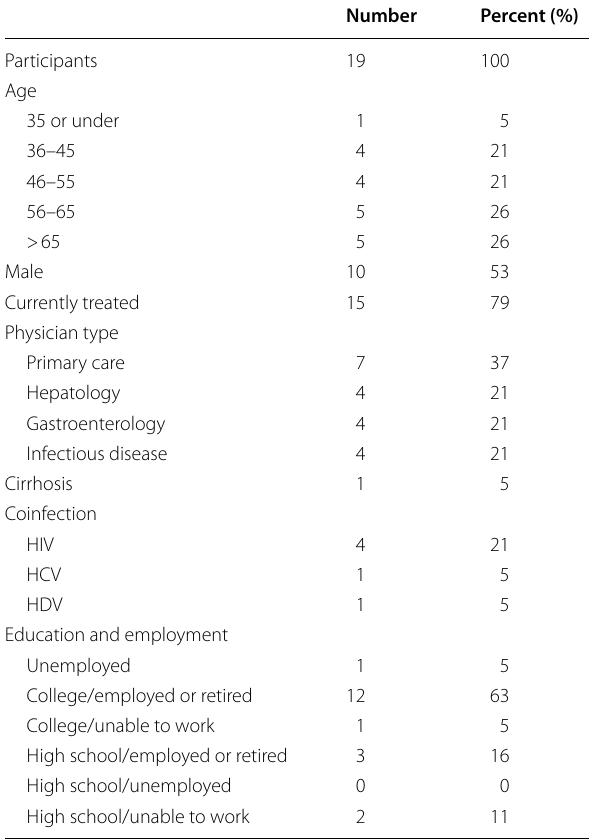
Table 1 Demographic characteristics for participant sample of those living with HBV in the United